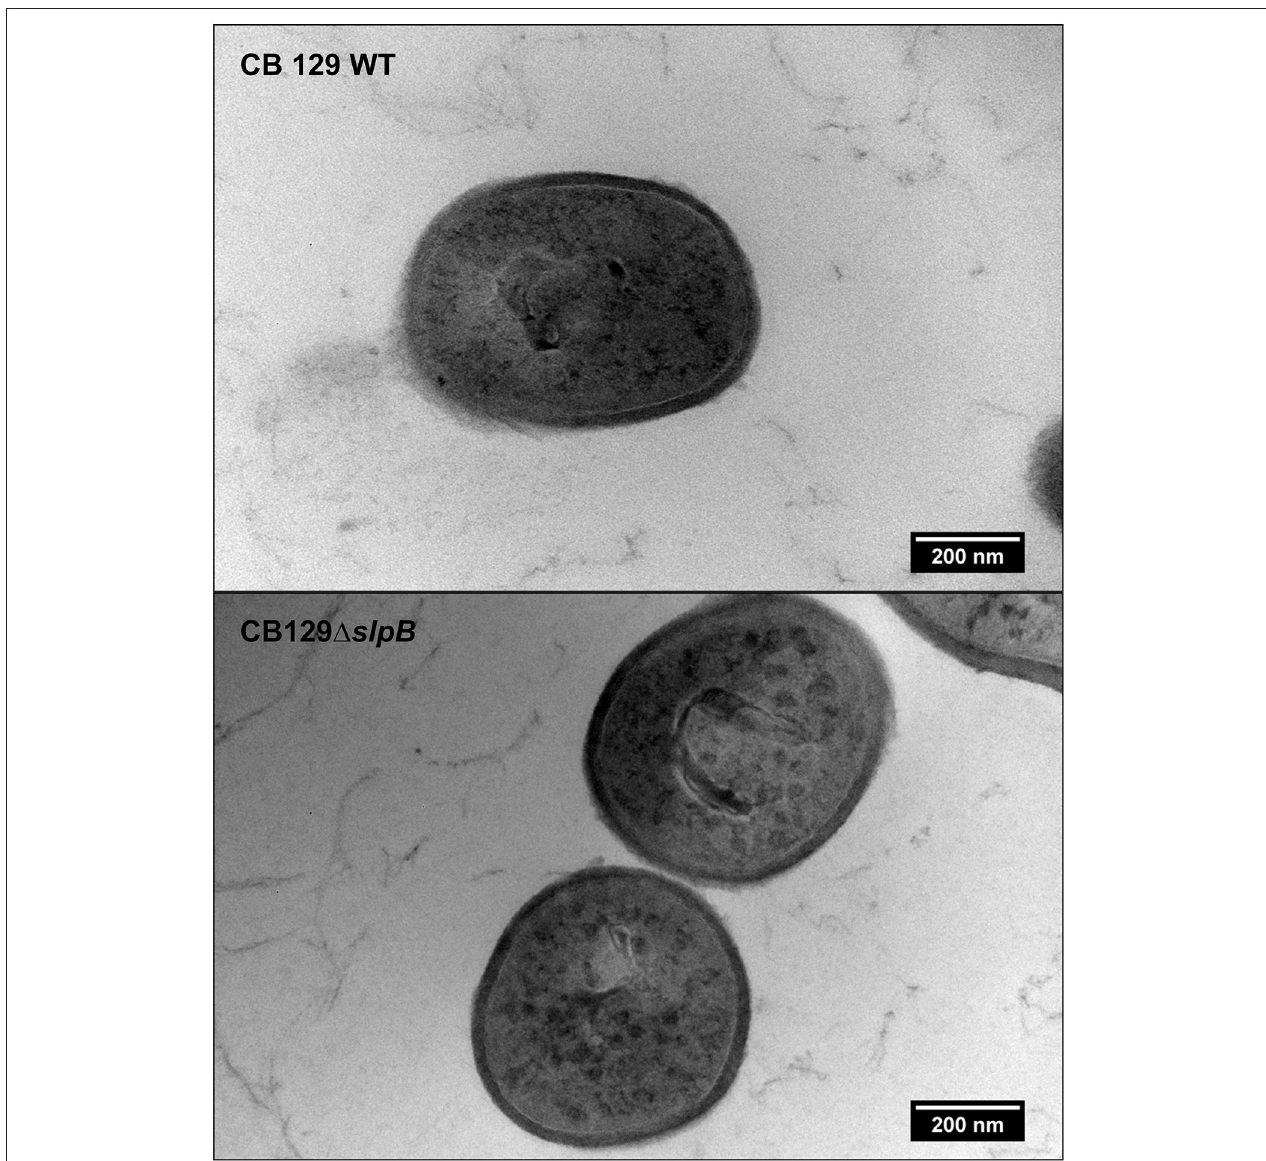
different biological process were dysregulated in the mutant strain. As seen in Figure 5B , 11 proteins were classified as having general functions, 10 proteins related to process of replication, recombination and repair, other 10 proteins linked to posttranslational modification, chaperones, protein turnover, and 9 proteins involved in the transcription process. The differentially expressed proteins between wild-type and mutant strains detected in each functional category are shown in Table 2